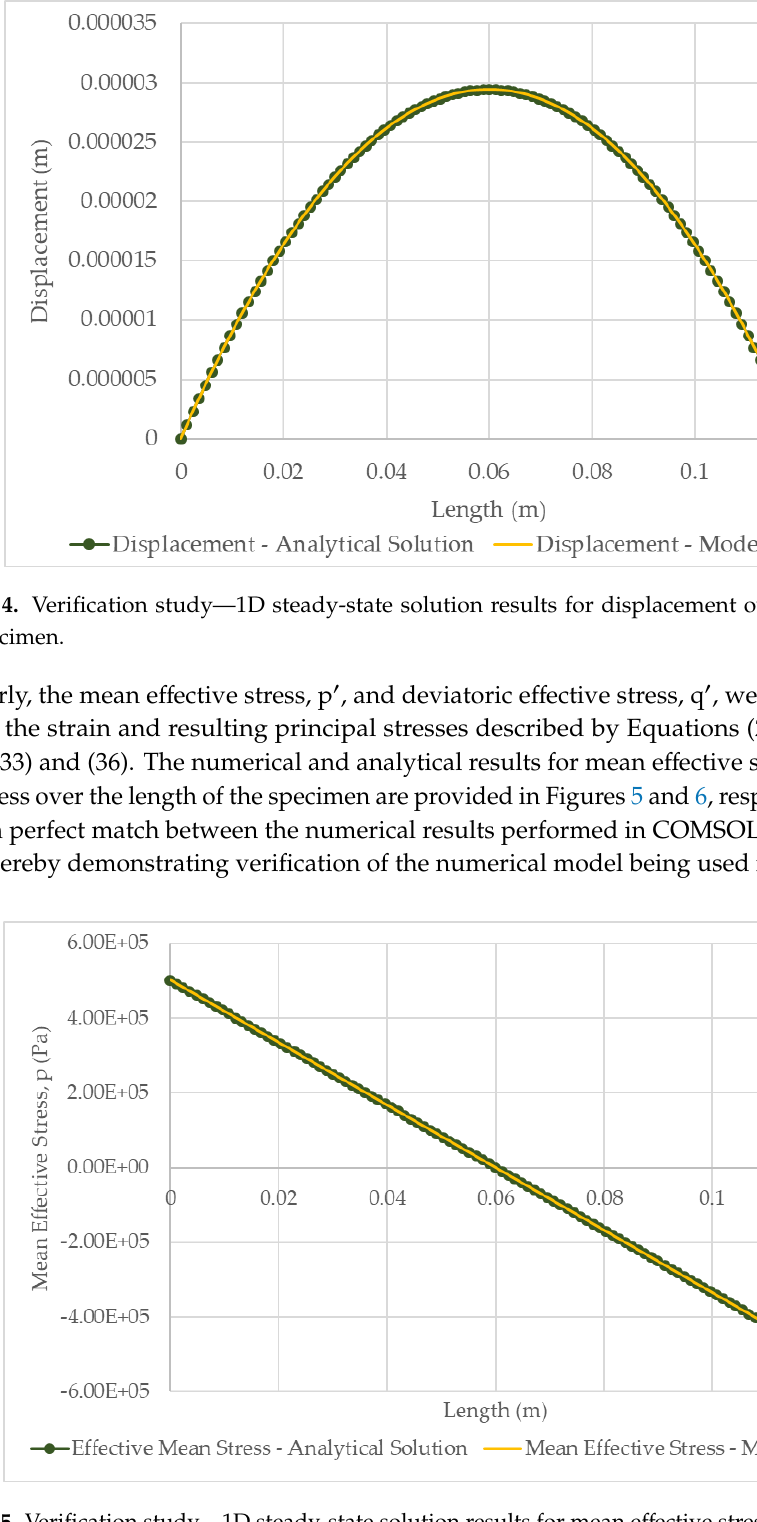
Figure 3. Verification study — 1D steady-state solution results for poregas pressure over the length of the specimen.